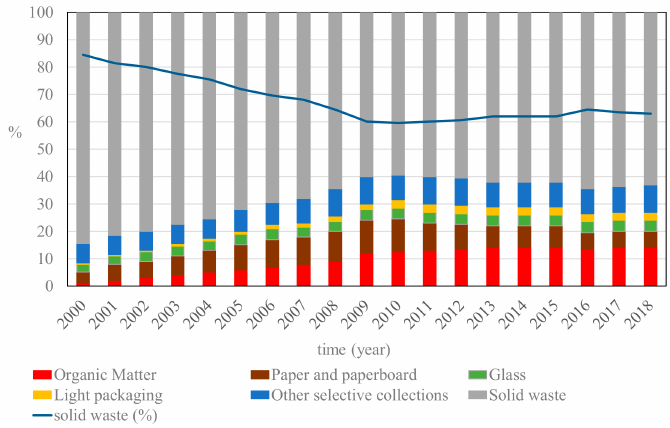
Figure 1. Catalan recycling tendency in the last few years